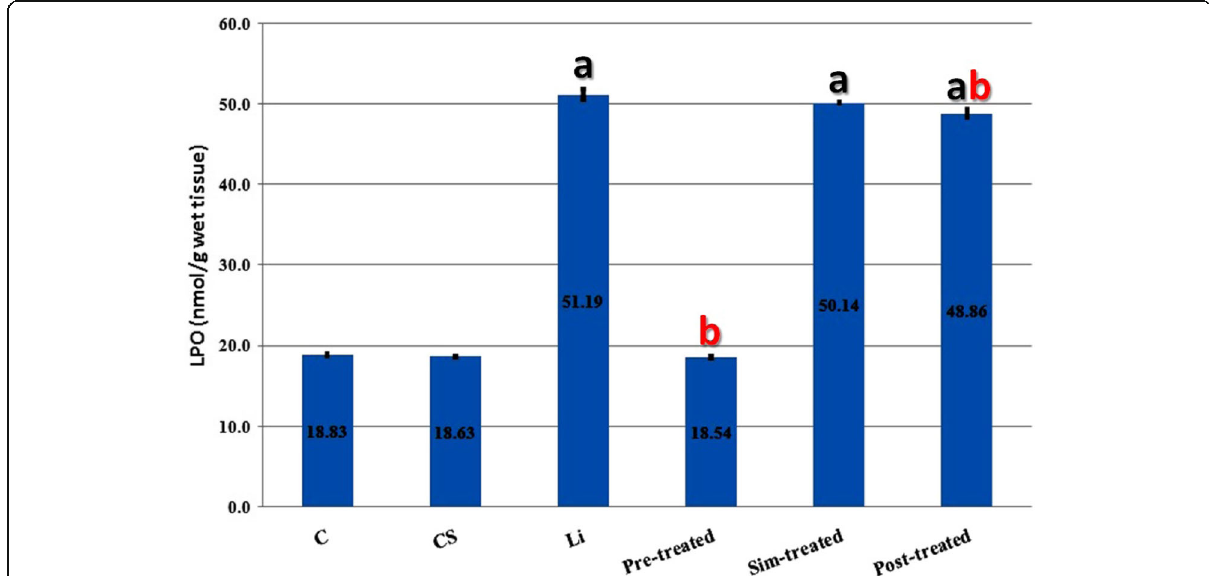
Fig. 2 Prophylactic and therapeutic effect of chitosan on renal LPO (lipid peroxidation product) level against Li 2 CO 3 -induced renal toxicity in rats. Bars represent the group means±SE. a Significant difference from control group at P <0.05. b Significant difference from Li-treated group at P